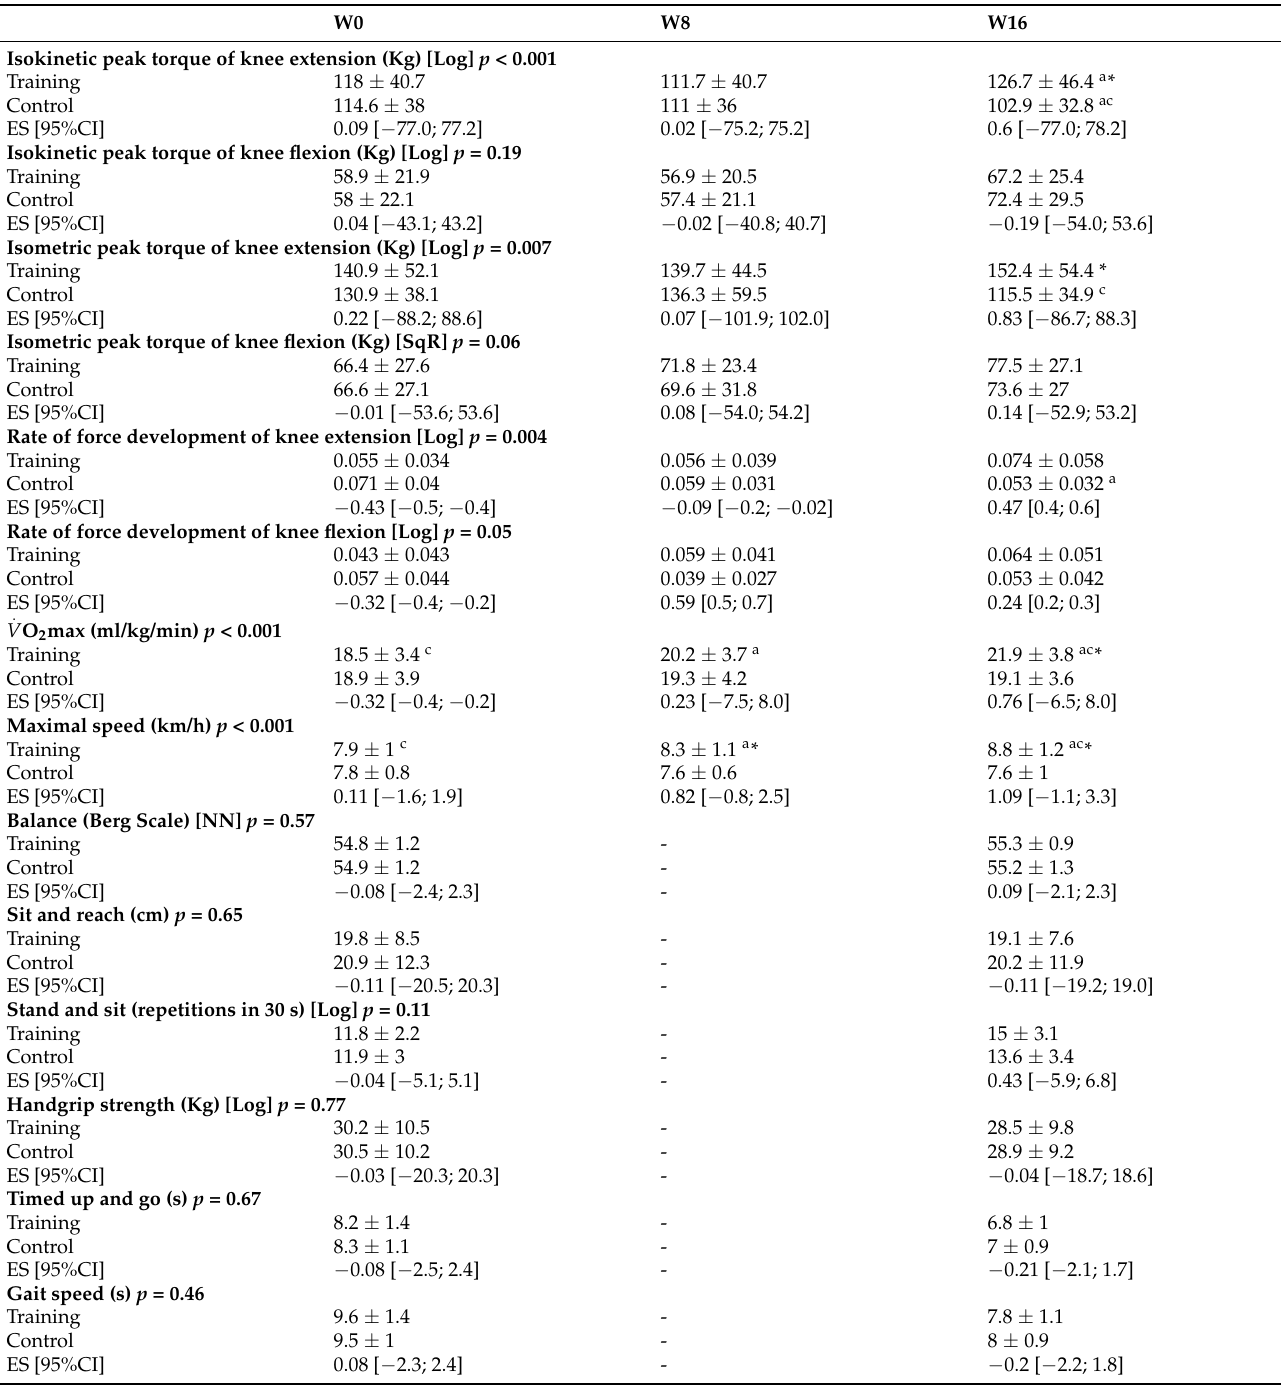
Table 3. Physical